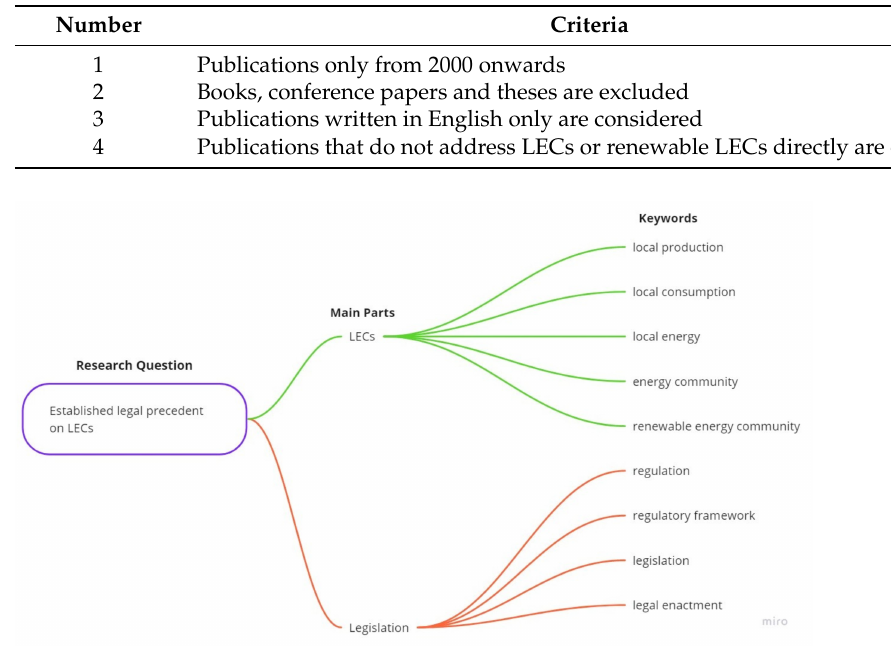
Table 1. Literature selection criteria.